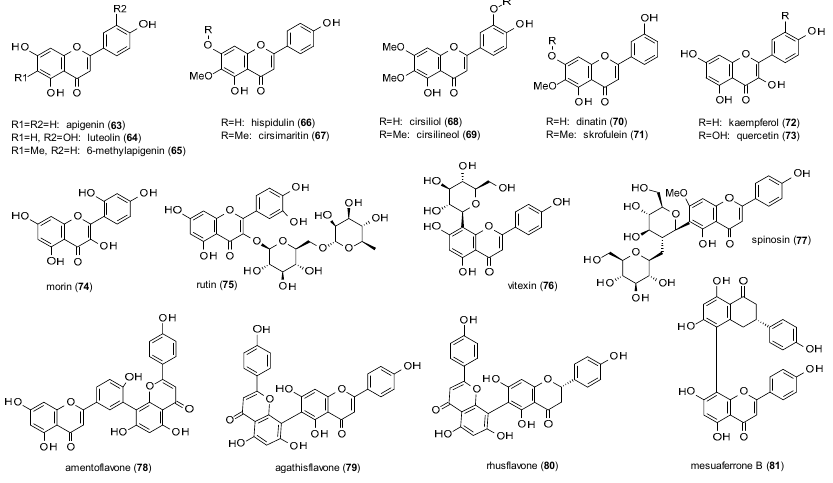
Figure 4. Chemical structures of other flavones with reported GABA(A)-receptor modulating activity.